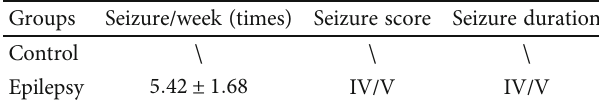
Table 1: Characteristics of SRS in TLE rats ( mean ± SD , n = 8 ).